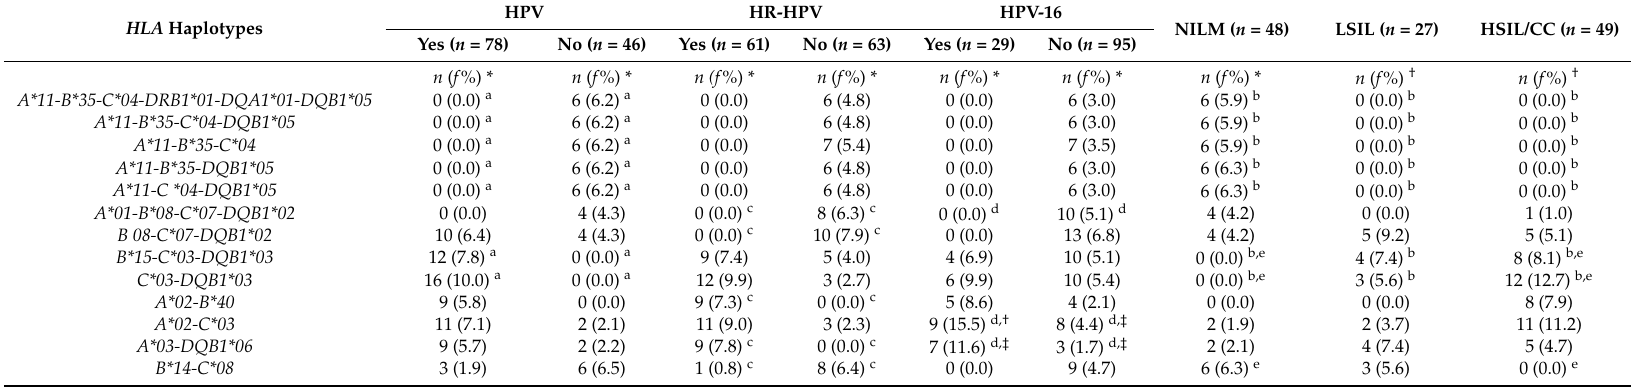
Table 4. Significant associations of HLA haplotypes with risk of HPV infection or cervical lesions/cancer development. HLA